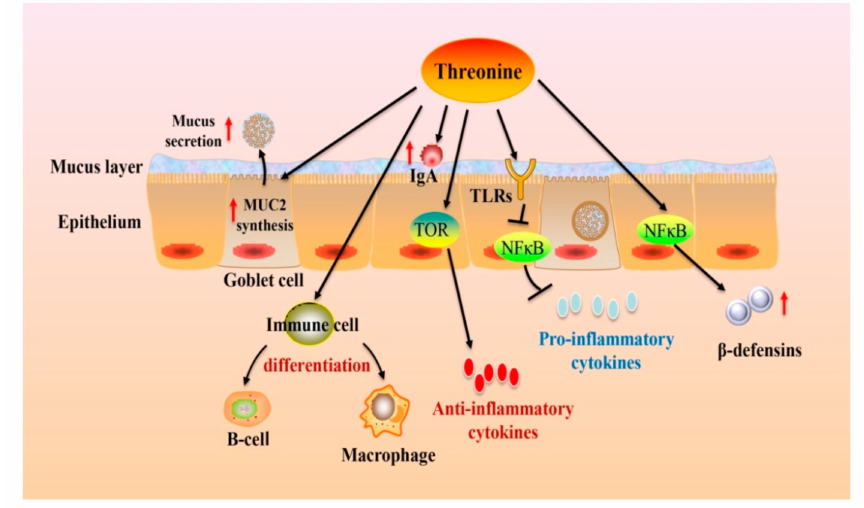
Figure 2. Dietary Thr modulates the intestinal immune function. Dietary Thr affects goblet cell differentiation, which, in turn, stimulates MUC2 synthesis. Thr regulates immune cell differentiation and immunoglobulins (Ig) production. Meanwhile, Thr can modulate the release of cytokines via the TOR and NF- κ B pathways. Abbreviations: IgA: immunoglobulins A; MUC2: mucin-2; TLRs: toll-like receptors; TOR: the target of rapamycin; NF- κ B: nuclear factor κ -light-chain-enhancer of activated B